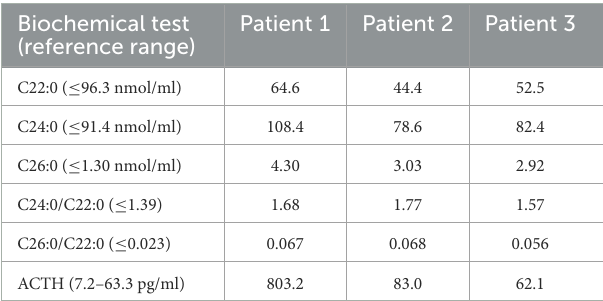
TABLE 2 Biochemical characteristics of three patients with AMN. Biochemical test (reference